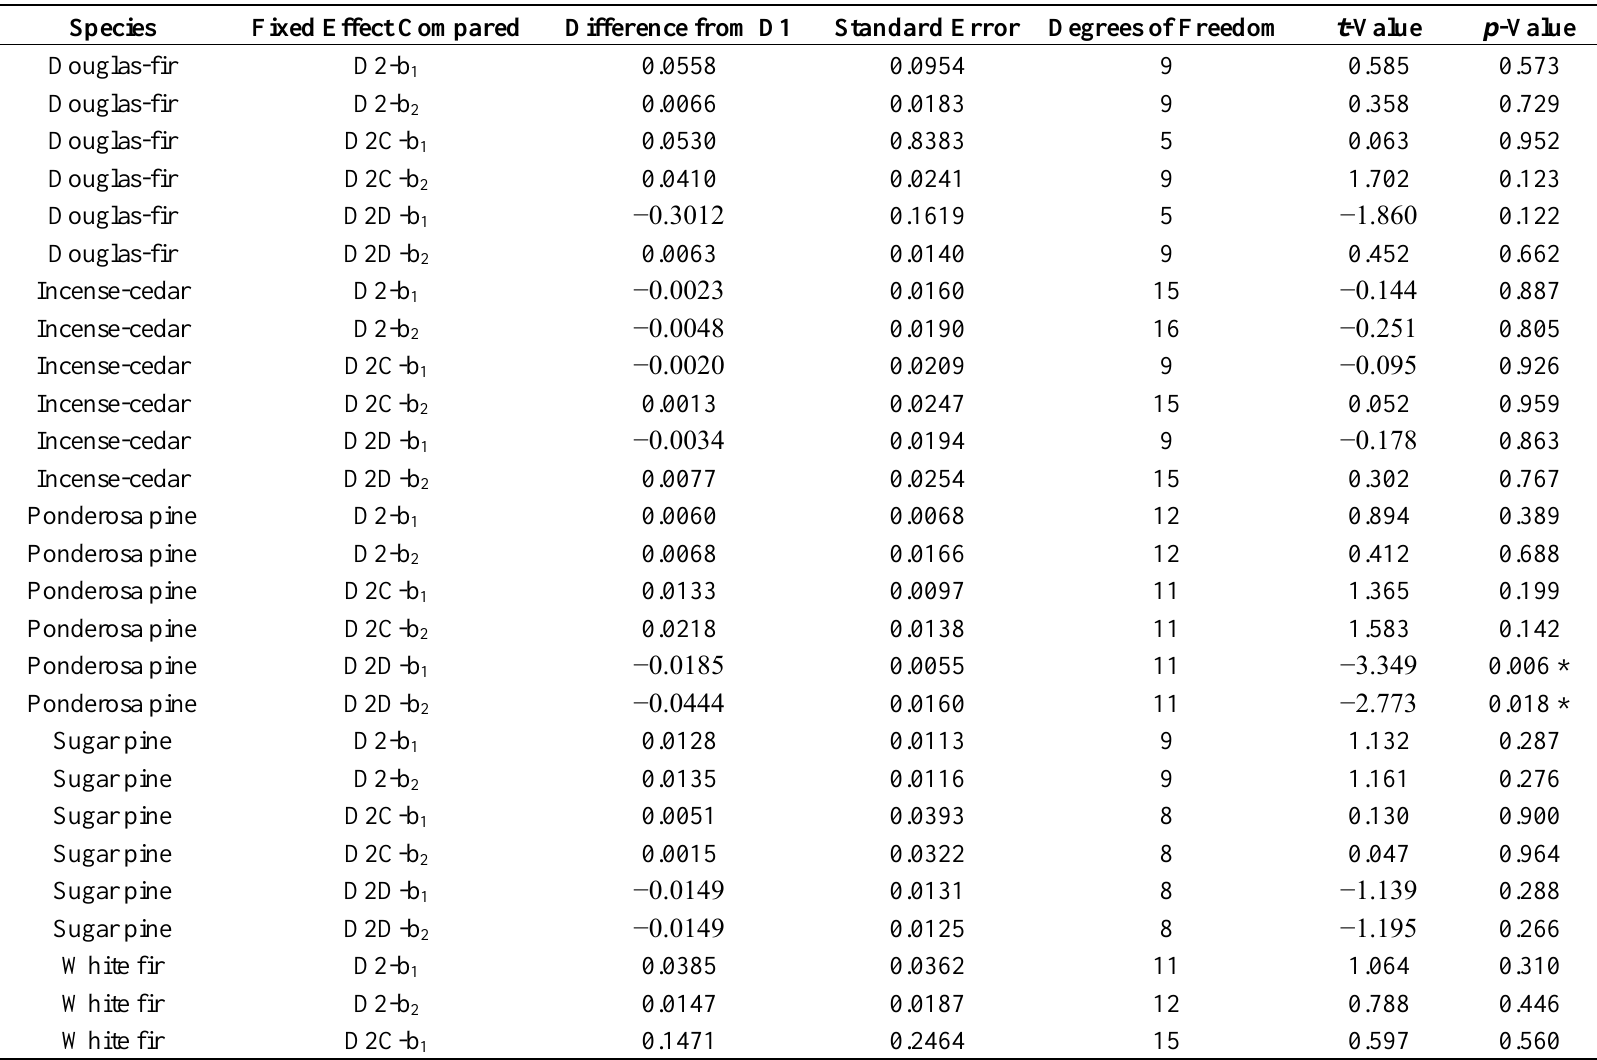
Table 8. Comparisons between fixed effect parameter estimates for D1 versus all other dataset categories (D2, D2C, and D2D).